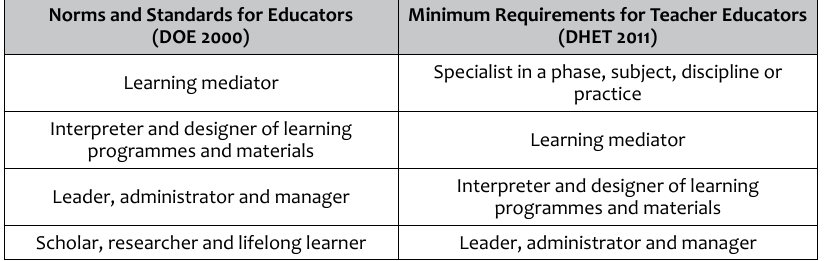
Table 1: Roles of the teacher educator Norms and Standards for Educators (DOE